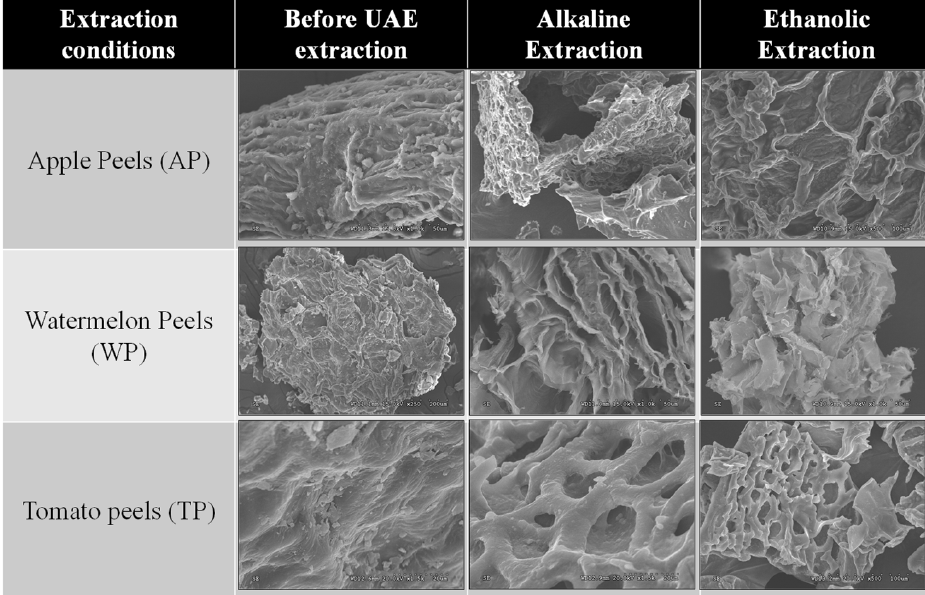
Figure 3. SEM images obtained for the different studied wastes before and after the UAE pro- cesses.